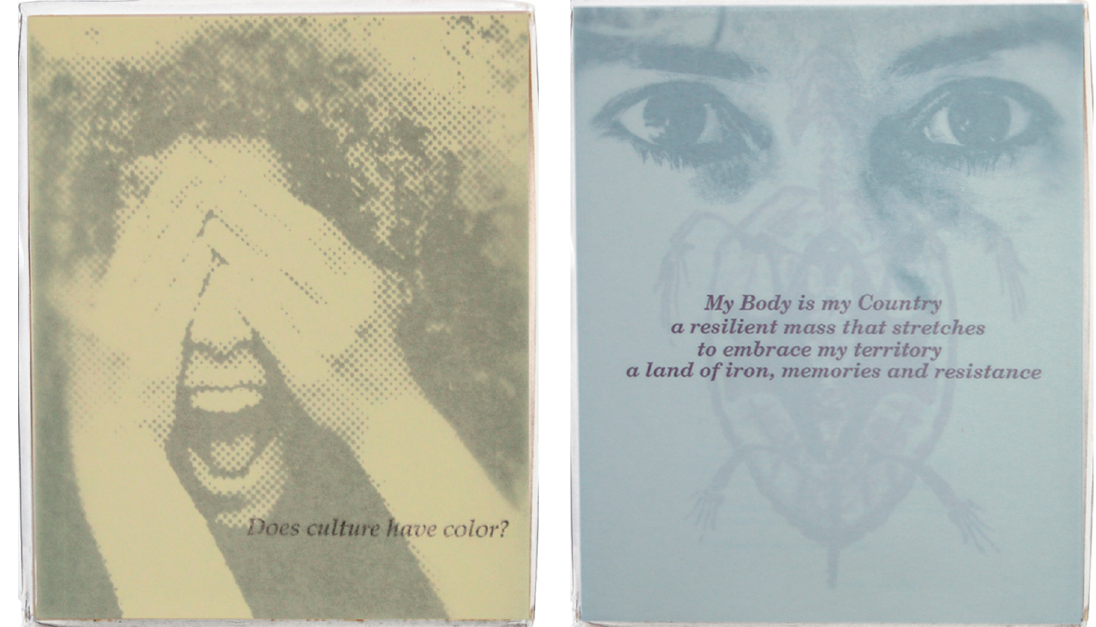
Figure 1. Josely Carvalho, My Body is My Country , 1991, Artist book, 12 pages, silkscreen and offset on paper, 8.26 × 7 × 0.98 inches. Courtesy of the artist.